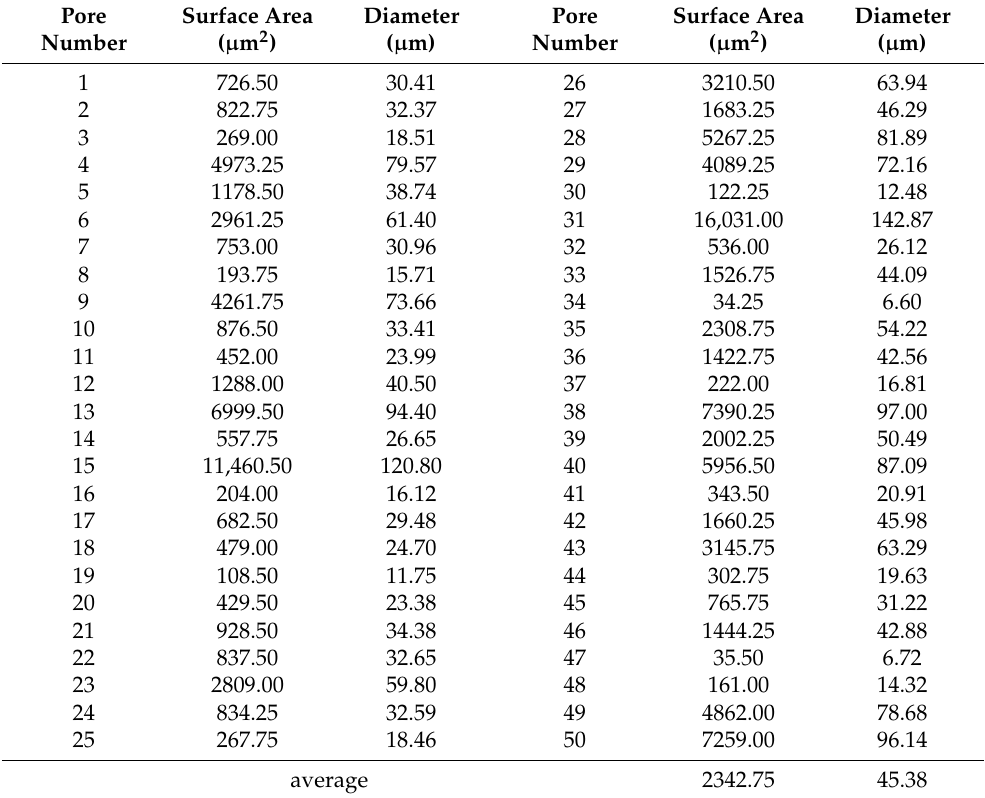
Table 5. Measurement results of pores extracted from SEM images for carbon sample